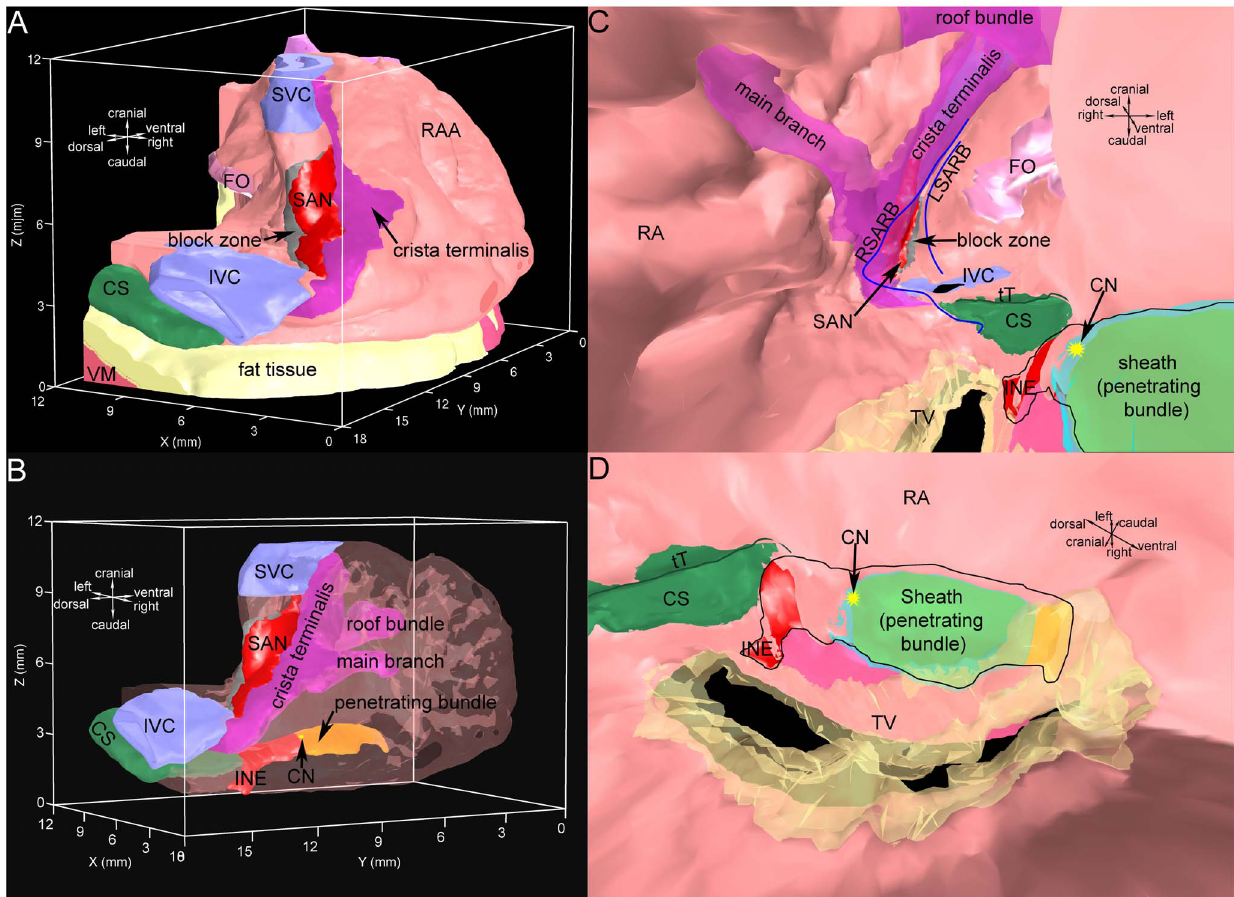
Figure 2. 3D model of the rabbit right atrium including the SAN and AVN. A, dorsal oblique view of the model. B, model with transparent atrium to reveal internal structures. C, internal ventral view of the model. D, internal cranial right view of the model. Different segmented structures are shown in different colours. CN, compact node; CS, coronary sinus; INE, inferior nodal extension; IVC, inferior vena cava; FO, fossa ovalis; LSARB, left sinoatrial ring bundle; RAA, right atrial appendage; RSARB, right sinoatrial ring bundle; SVC, superior vena cava; tT, tendon of Todaro; TV, tricuspid valve.